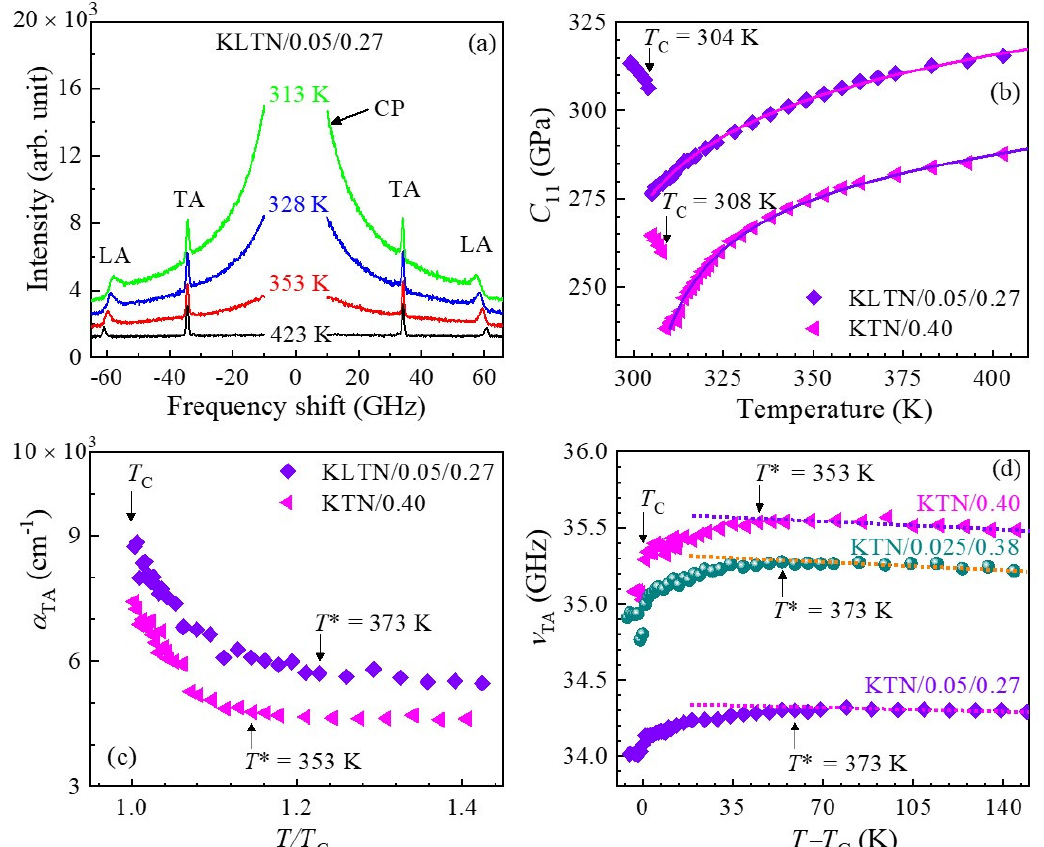
Figure 5. ( a ) Brillouin scattering spectra of the KLTN/0.05/0.27 single crystal at some selected temperatures recorded with FSR = 75 GHz. ( b ) Temperature-dependent elastic constant C 11 of both KTN/0.40 and KLTN/0.05/0.27 single crystals. The solid lines are the best fit result obtained from Equation (11) ( c ) The attenuation of the TA mode in the KTN/0.40 and KLTN/0.05/0.27 crystals as a function of T/T C . ( d ) The observed frequency shift of the TA mode of KTN/0.40, KLTN/0.025/0.38, and KLTN/0.05/0.27 crystals as a function of normalized temperature. The short dashed lines are guides to the eyes. The data were adapted from Refs. [27,58].